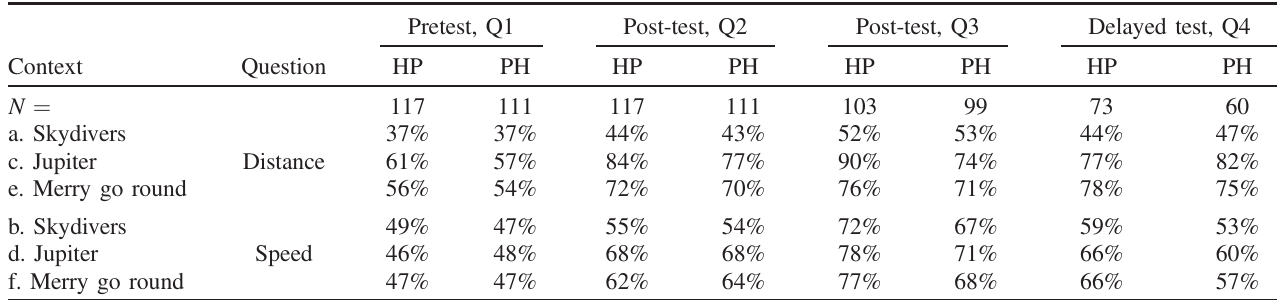
TABLE II. The percentage of correct answers to the two questions in the three contexts are shown for each questionnaire (Q1, Q2, Q3, Q4) for HP and PH groups. The total number of students is given in each case. Pretest, Q1 Post-test, Q2 Post-test, Q3 Delayed test,